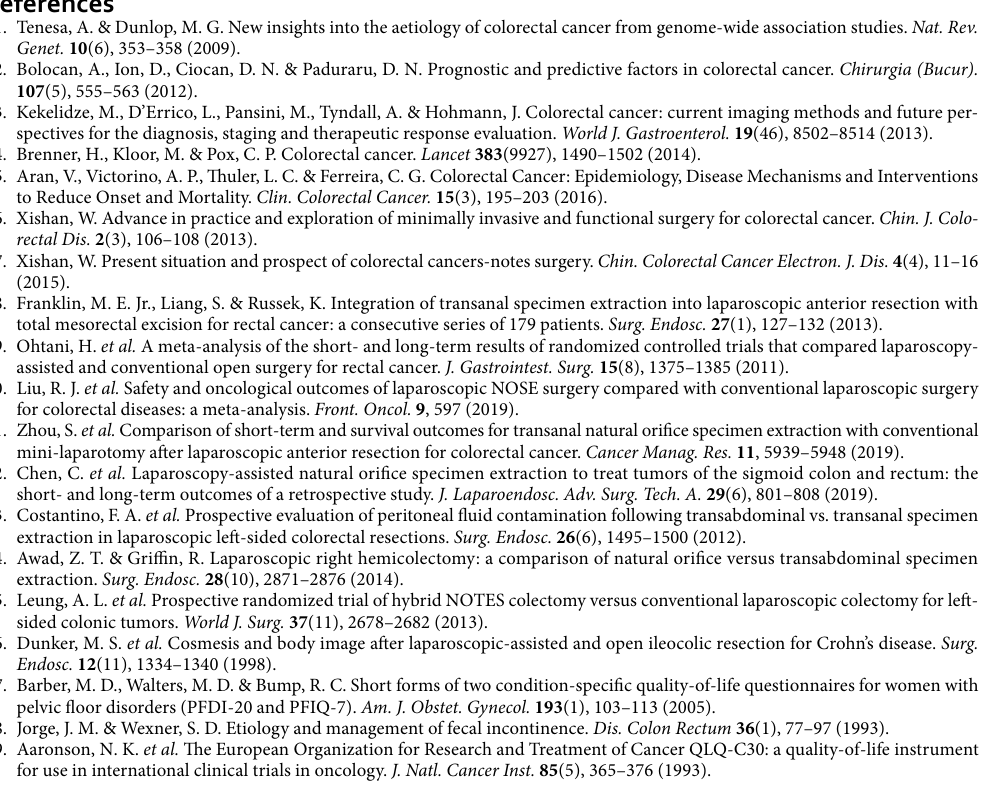
Table 1) to assess patients’ anal function at 6 months postoperatively. EORTC QLQ-C30 is the core scale of the Quality of Life Measurement Scale System for Cancer Patients developed by the European Organization for Re- search and Treatment (EORTC) to determine the quality of life of all cancer patients 19 . In the present study, we used this score to assess the quality of life of patients 3 months after